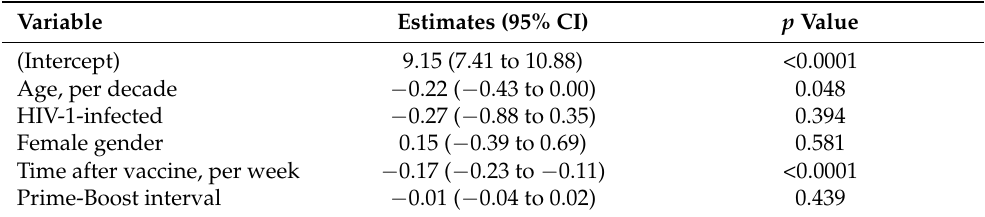
Table 2. Multivariate linear regression analysis of the serum spike-specific IgG levels among SARS- CoV-2 vaccinated subjects.